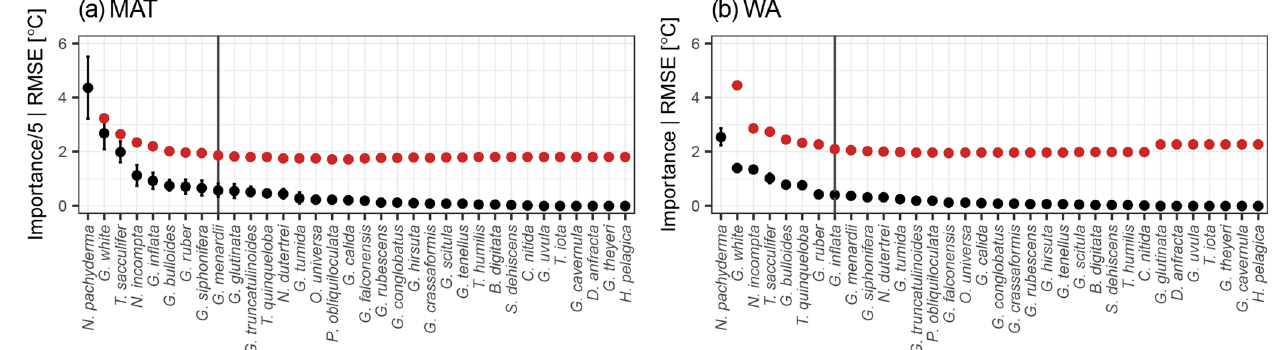
Figure 1. Species importance (black) and transfer function performance (red) for models including all species to the left of the point (e.g. the first red point for the MAT transfer function for the North Atlantic denotes the prediction error (root mean square error; RMSE) of a model with N. pachyderma and G. ruber (white). Error bars on the species importance show the standard deviation of 10 replicates; see “Data and methods” for details. The dark vertical lines indicate the species needed for a transfer function model in which including more species only leads to a marginal reduction in the reconstruction error (arbitrarily set at when the prediction error is within 10% of the minimum). Note that for display purposes the species importance for MAT has been divided by a factor of